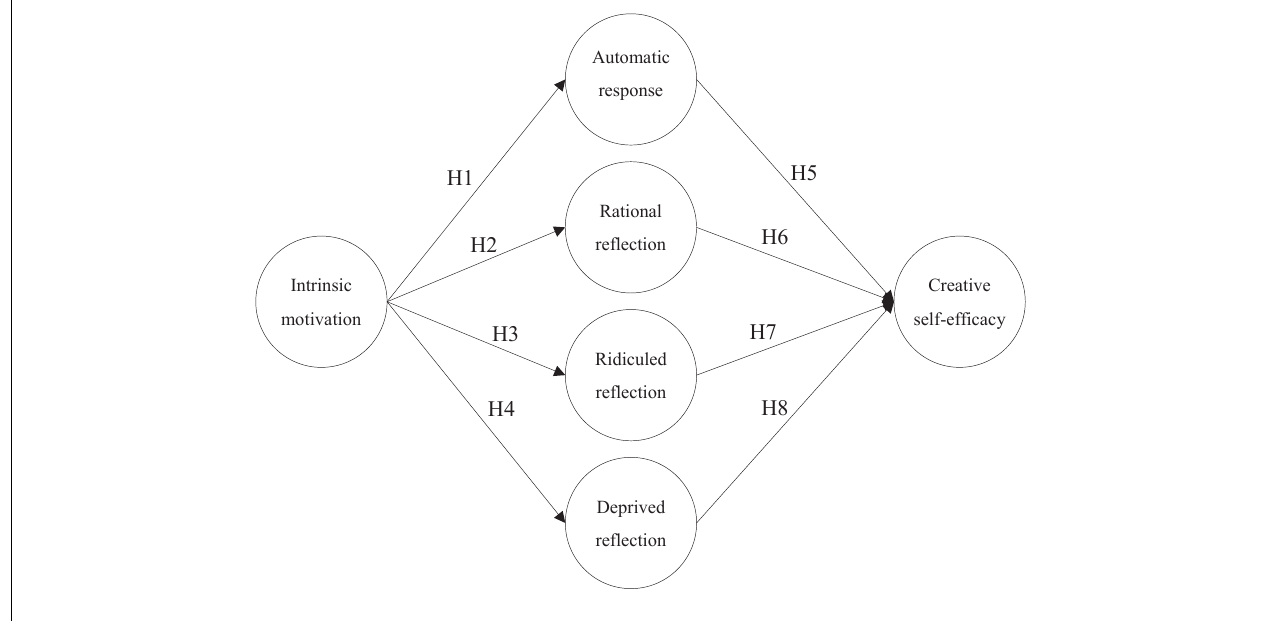
FIGURE 1 | Research